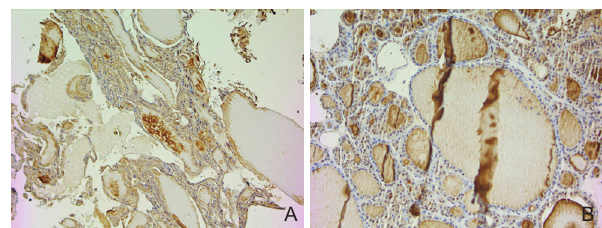
Figure 2 Expressions of HSP70 in central zones of thyroid adenoma before and shortly after thermal ablation (×200). (A) weak expressions of HSP70 in the central zone before ablation; (B) weak expressions of HSP70 in the central zone shortly after ablation. Table 1 Expressions of HSP70 in the same zones of benign thyroid nodules before and after thermal ablation